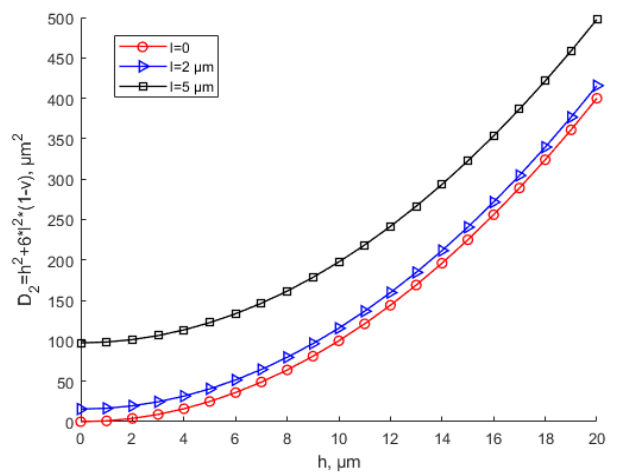
Figure 3. Effects of the scale parameter on equivalent bending stiffness based on CT and MCST.